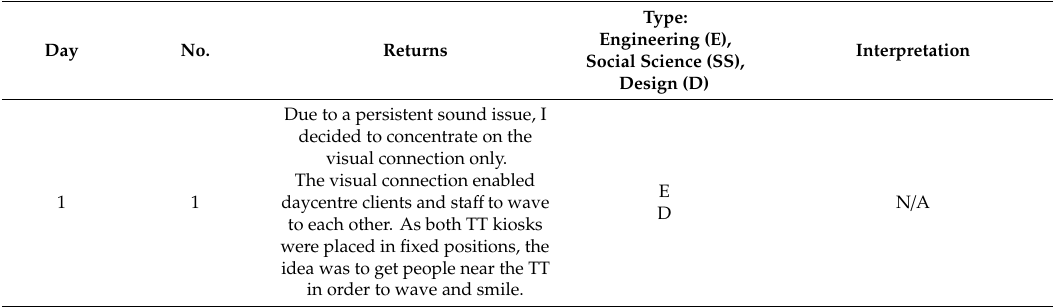
Table A4. Returns collected from the third in-the-wild